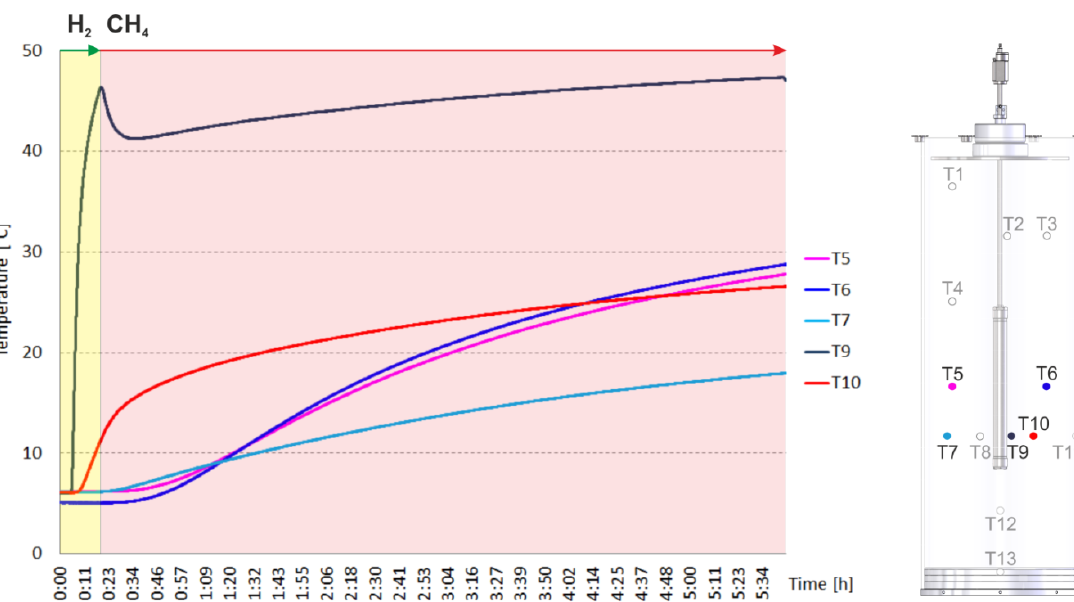
Figure 4. Left: Temperature profiles versus time for the heating experiment using the reactor in sediment + water without external cooling. Right: Positions of the temperature sensors within LARS, empty circles show positions of temperature sensors whose profiles are not shown in the